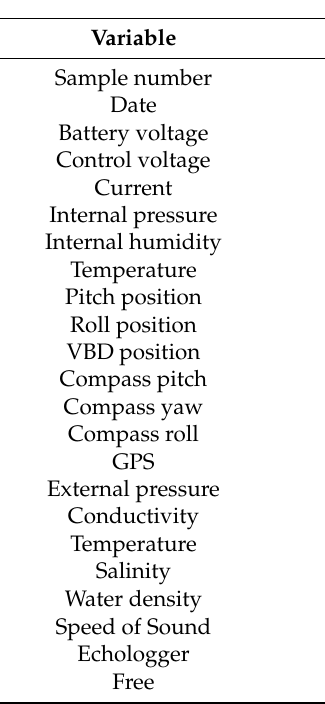
Figure 1. AUV developed at CIDESI. Table 1. Variables of our submarine